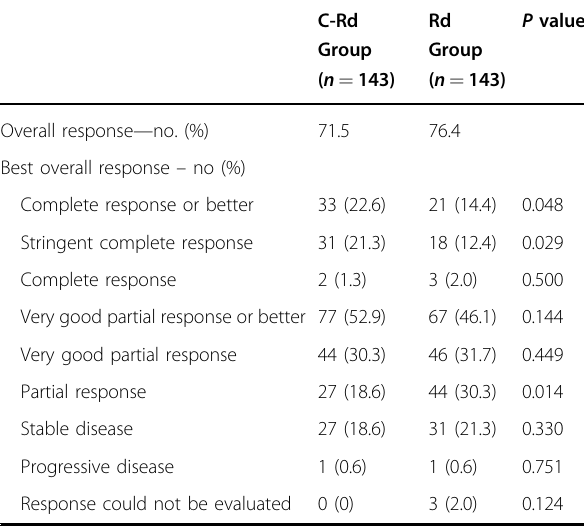
Table 3 Summary of response